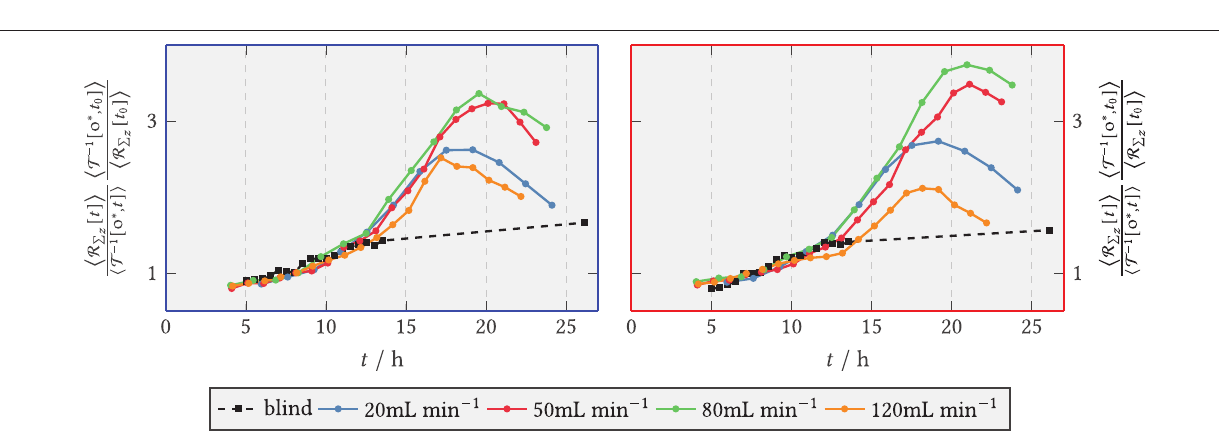
FIGURE 14 | Relative axial red fluorescence ( R ) sum of tagged glucoamylase for ˙ V = 20,50,80,120 mL min − 1 and the blank sample (shear-free medium exchange) divided by the relative biomass per time. The light extinction and the biomass were normalized to the initial extinction and the initial biomass at t 0 = 9 h. (Left) Zone behind the step (recirculation zone); (Right) zone downstream of the step, x / s > 15 (after